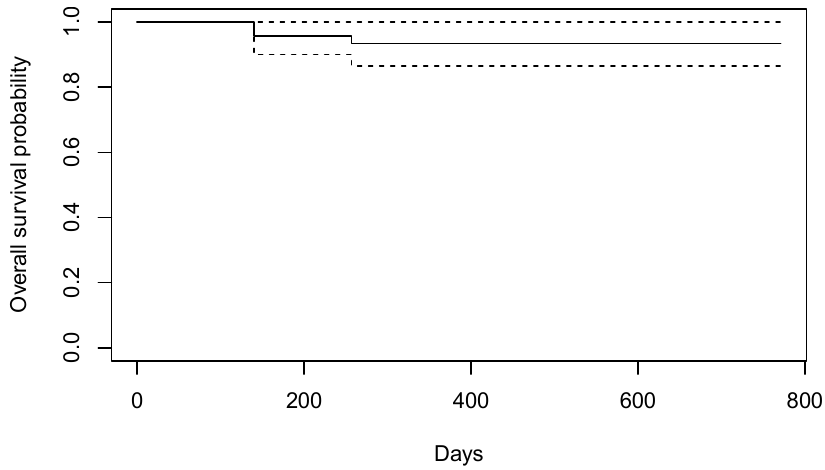
Figure 5. Kaplan–Meier survival plot, including the 95% confidence intervals.